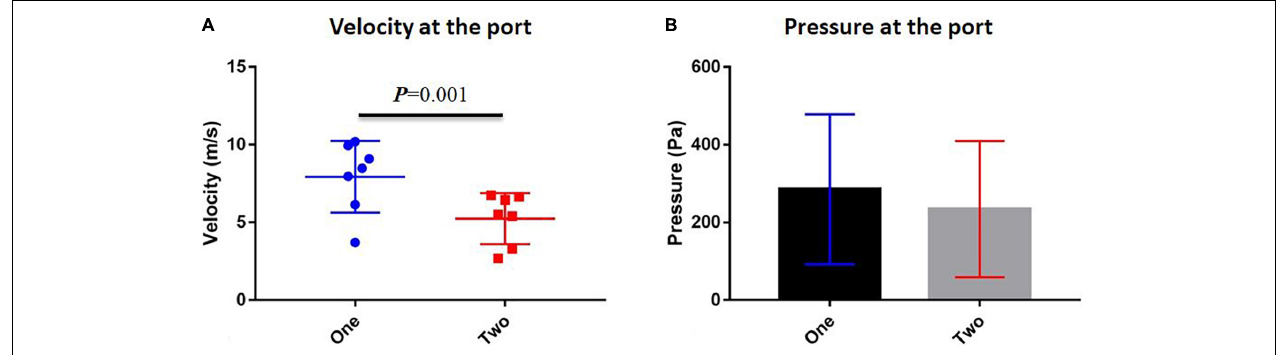
FIGURE 5 | Comparison between one-port and two-port velopharyngeal closures. (A) Velocity at the velopharyngeal port and (B) pressure at the velopharyngeal port. Error bars are S.D.